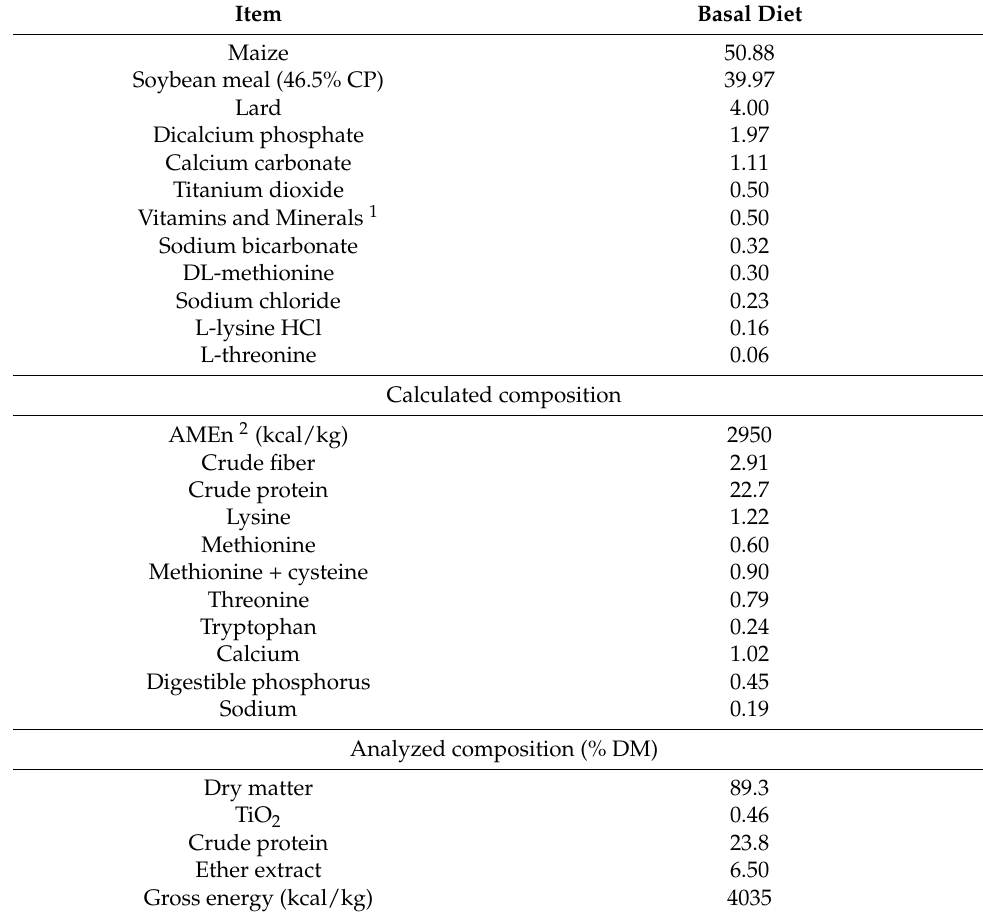
Table 1. Ingredients calculated and analyzed chemical composition of the basal diet (%, as fed basis, unless otherwise